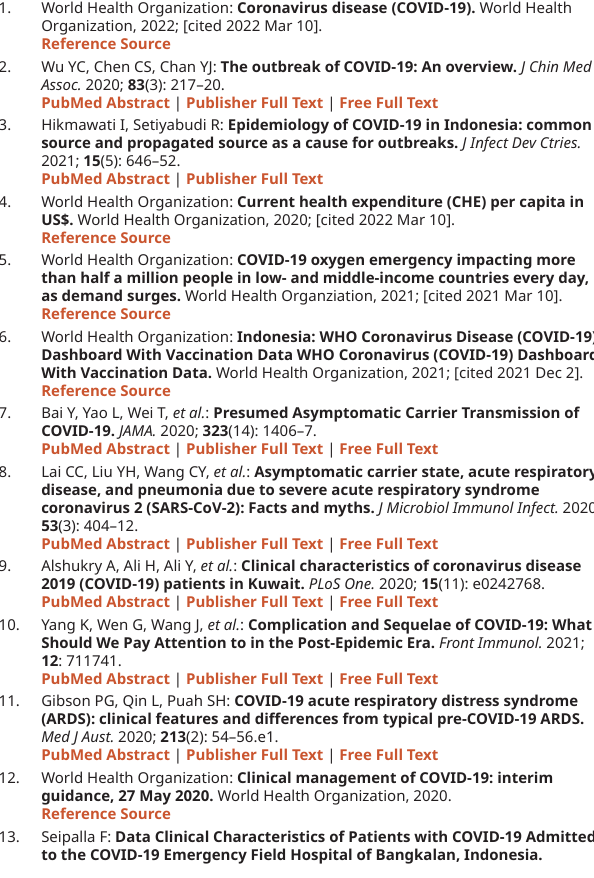
figshare. Dataset. 2022.